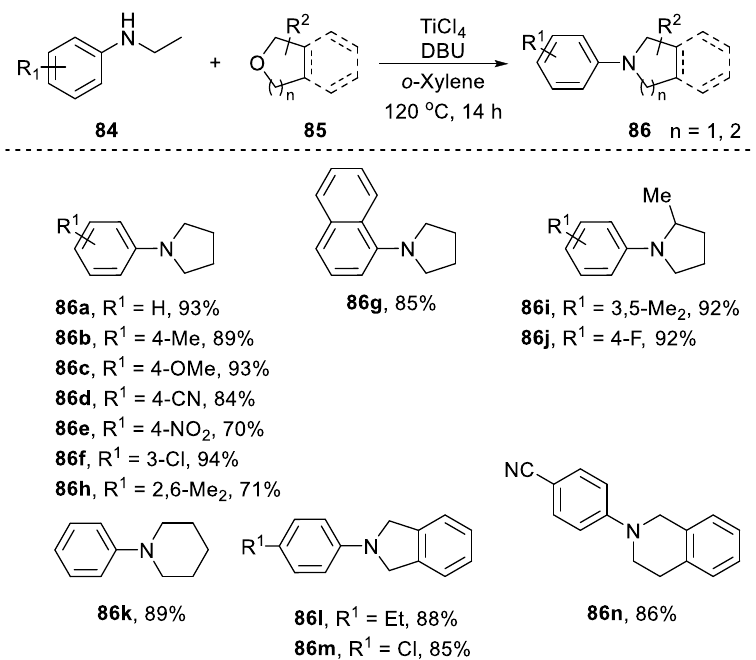
Scheme 18. Plausible mechanism of TiCl 4 - mediated reaction of aniline with